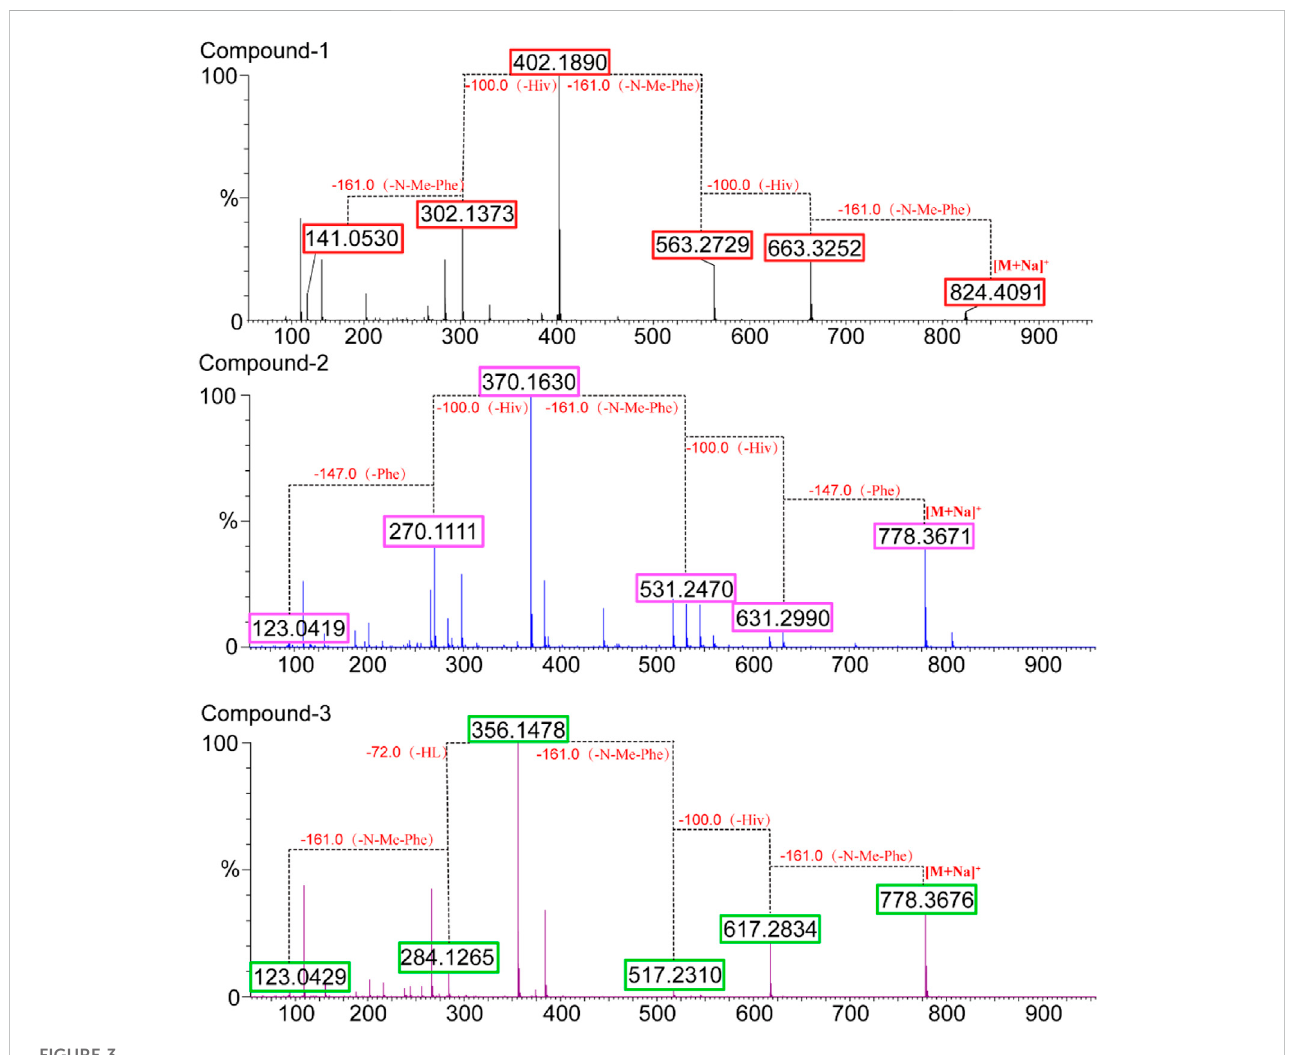
Fragments observed for compounds 1 – 3 b y